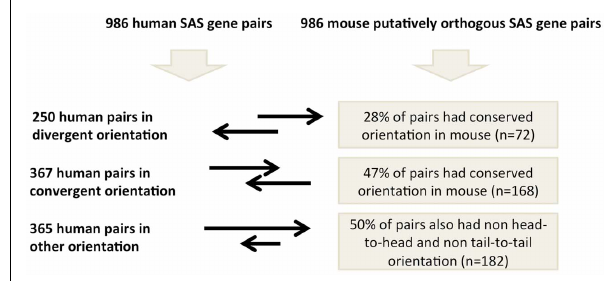
FIGURE 5 | Transcriptional activity at the 2227 mouse orthologs of human sense-antisense